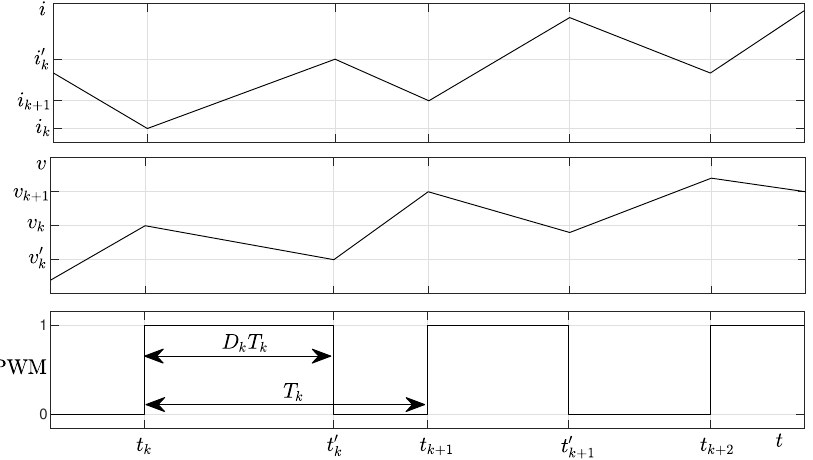
Figure 2. Typical waveforms during electrical transients for i (top panel), v (middle panel), and the PWM driving signal (bottom panel).